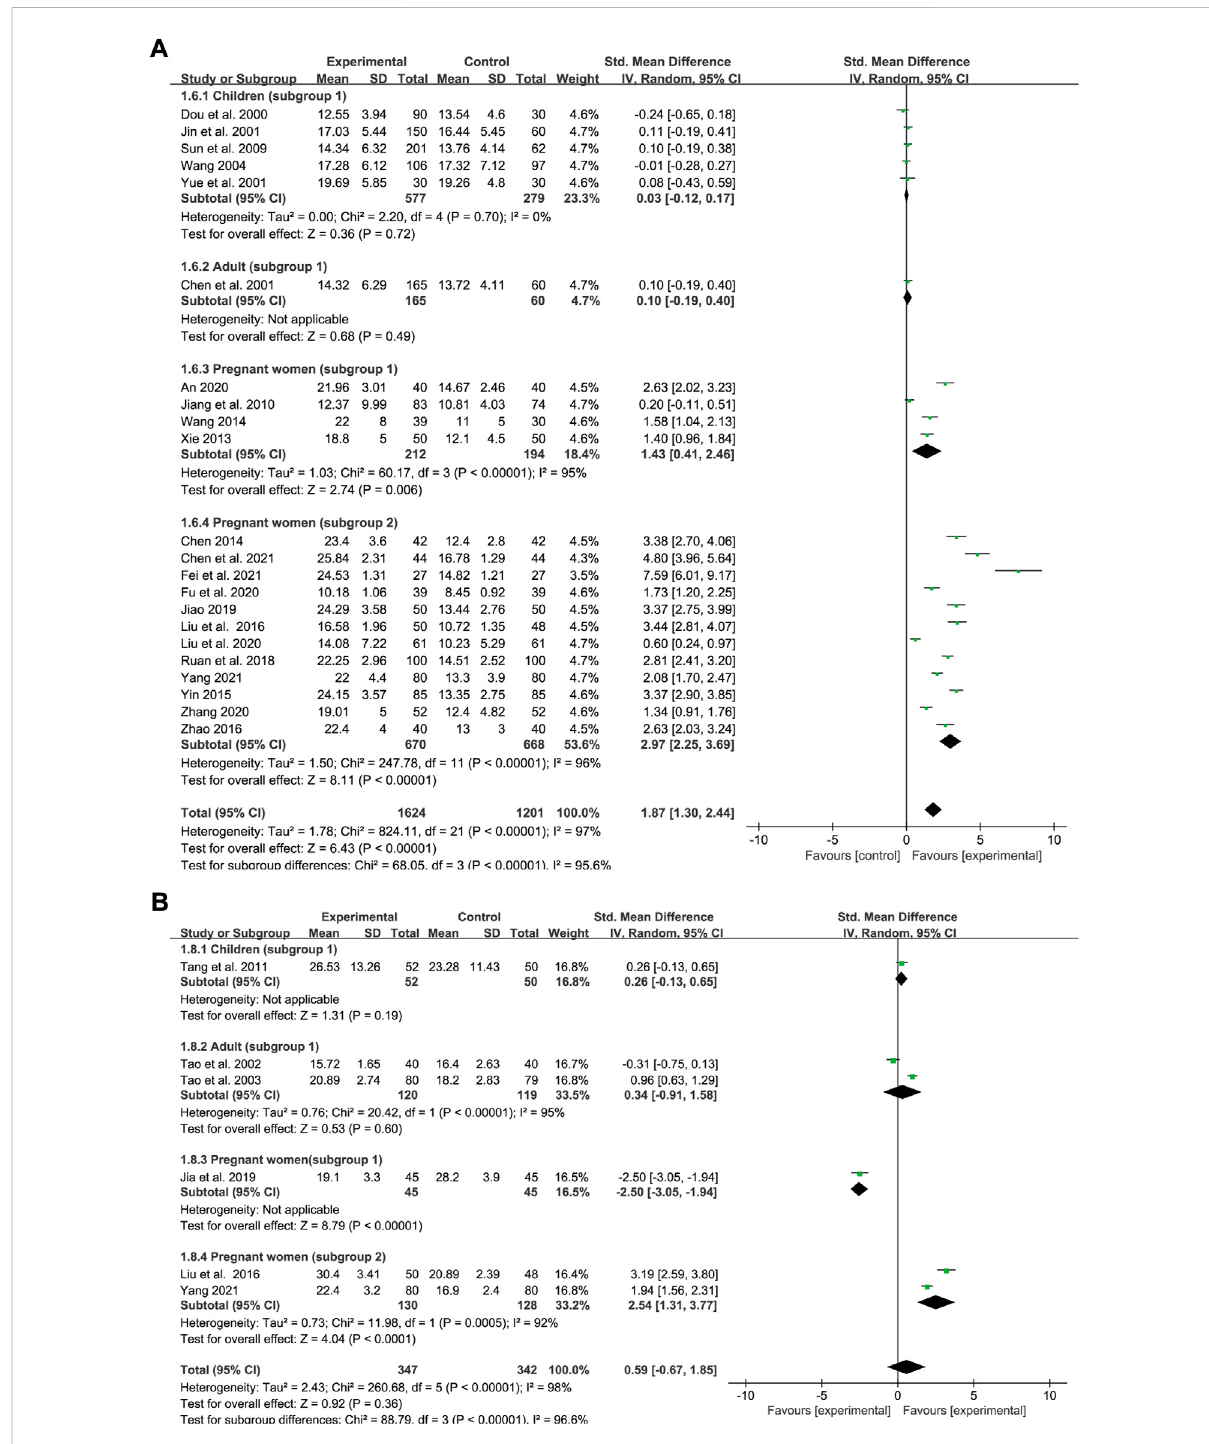
FIGURE 7 The forest plot assessing the effect of SXN on SI (A) , and SF (B)